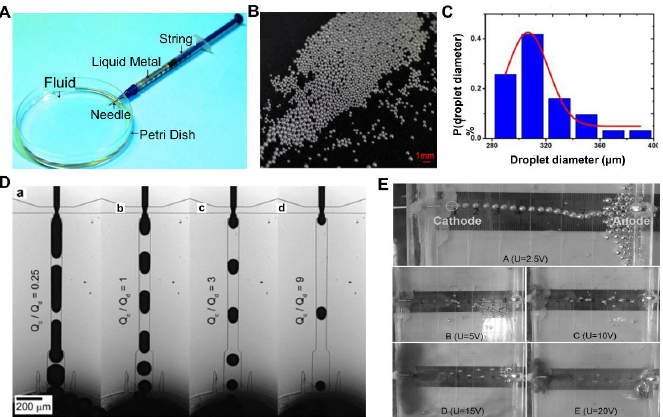
Figure 2. Fabrication methods of liquid metal (LM) droplets. ( A ) Device of fluidic jetting for LM droplet fabrication. Reprinted with permission from ref. [2]. Copyright 2013, John Wiley and Sons. ( B ) Optical image of LM droplets. Reprinted with permission from ref. [2]. Copyright 2013, John Wiley and Sons. ( C ) Histogram of droplet diameter distribution fabricated by fluidic jetting. Re- printed with permission from ref. [2]. Copyright 2013, John Wiley and Sons. ( D ) Micrographs of LM droplet fabrication at different flow rate ratios. Here, Q c is the volumetric flow rate of the continuous phase, Q d is the volumetric flow rate of LM. Reprinted with permission from ref. [78]. Copyright 2012, John Wiley and Sons. ( E ) The electro-hydrodynamic shooting phenomenon at different volt- ages. Reprinted with permission from ref. [83]. Copyright 2014, AIP Publishing.